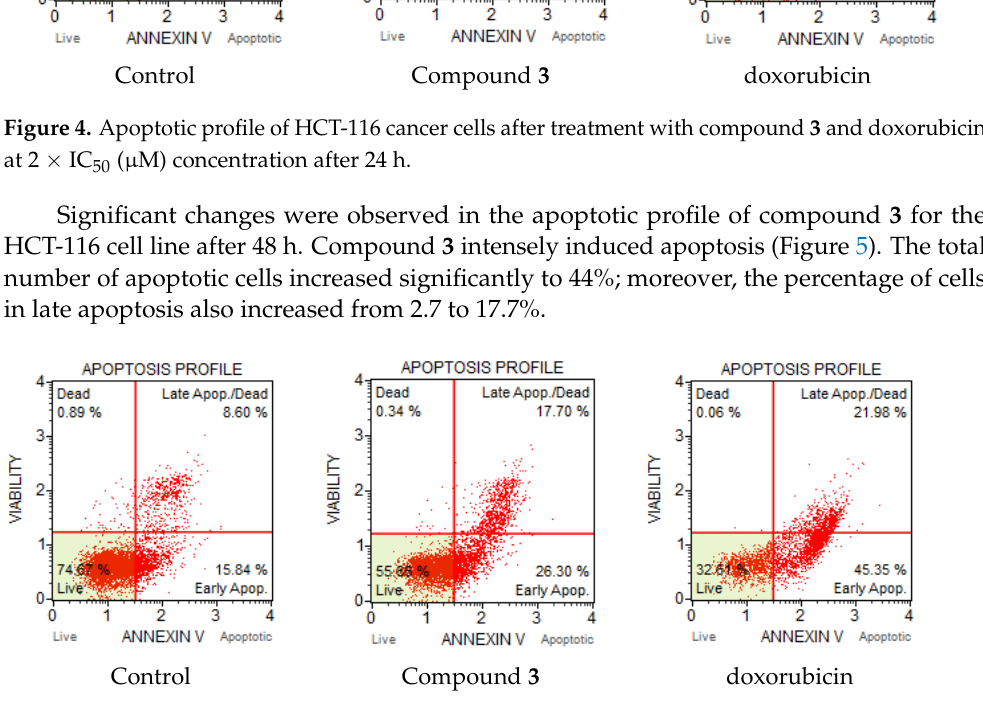
Figure 5. Apoptotic profile of HCT-116 cancer cells after treatment with compound 3 and doxorubicin at 2 × IC 50 ( μM ) concentration after 48 h.